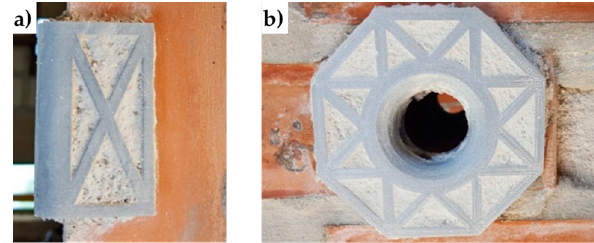
Figure 24. 3D printed elements after placing in place: ( a ) rounded angles, and ( b ) funnel plates.